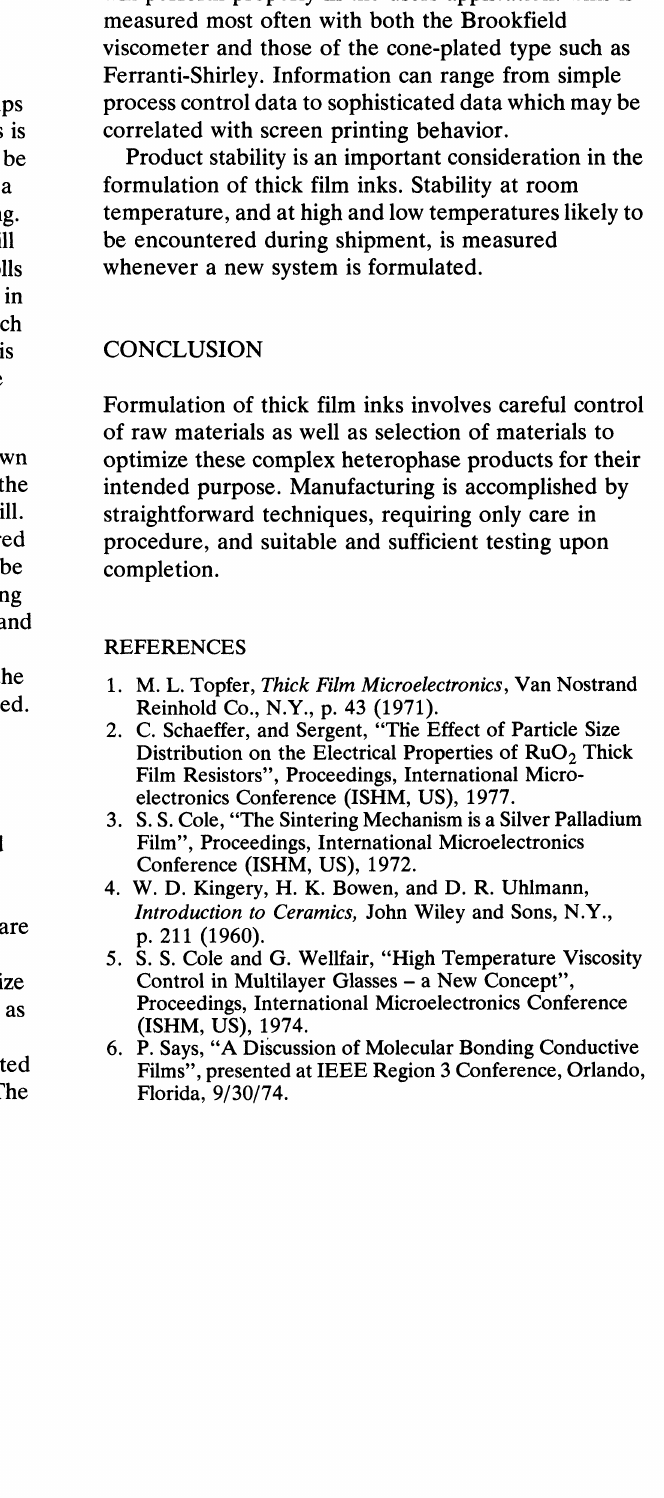
FIGURE 9 Roll action with three roll